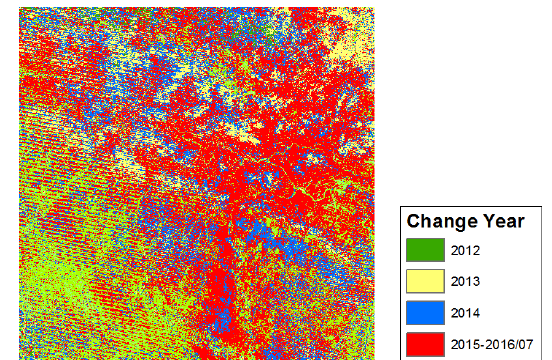
Figure 5. Breakpoint detected by Bfast Monitor with year and